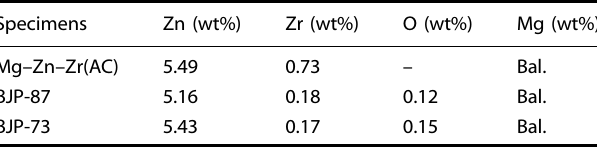
Table 3. Elemental composition of samples.